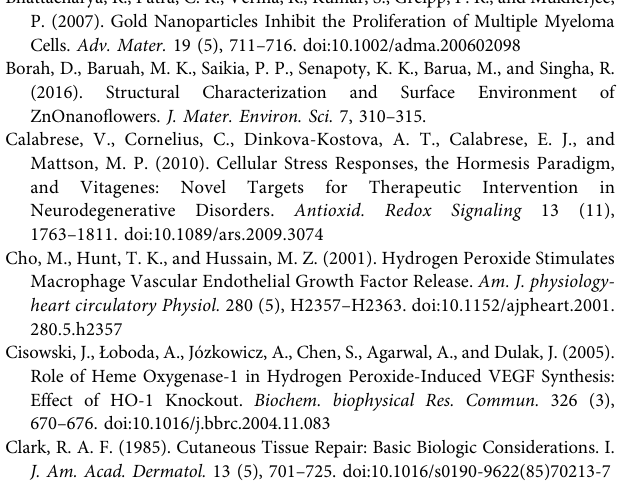
Supplementary Figure 1 | The image of preparation Zinc oxide nanorod. Supplementary Figure 2 | Another image of TEM of Zinc oxide